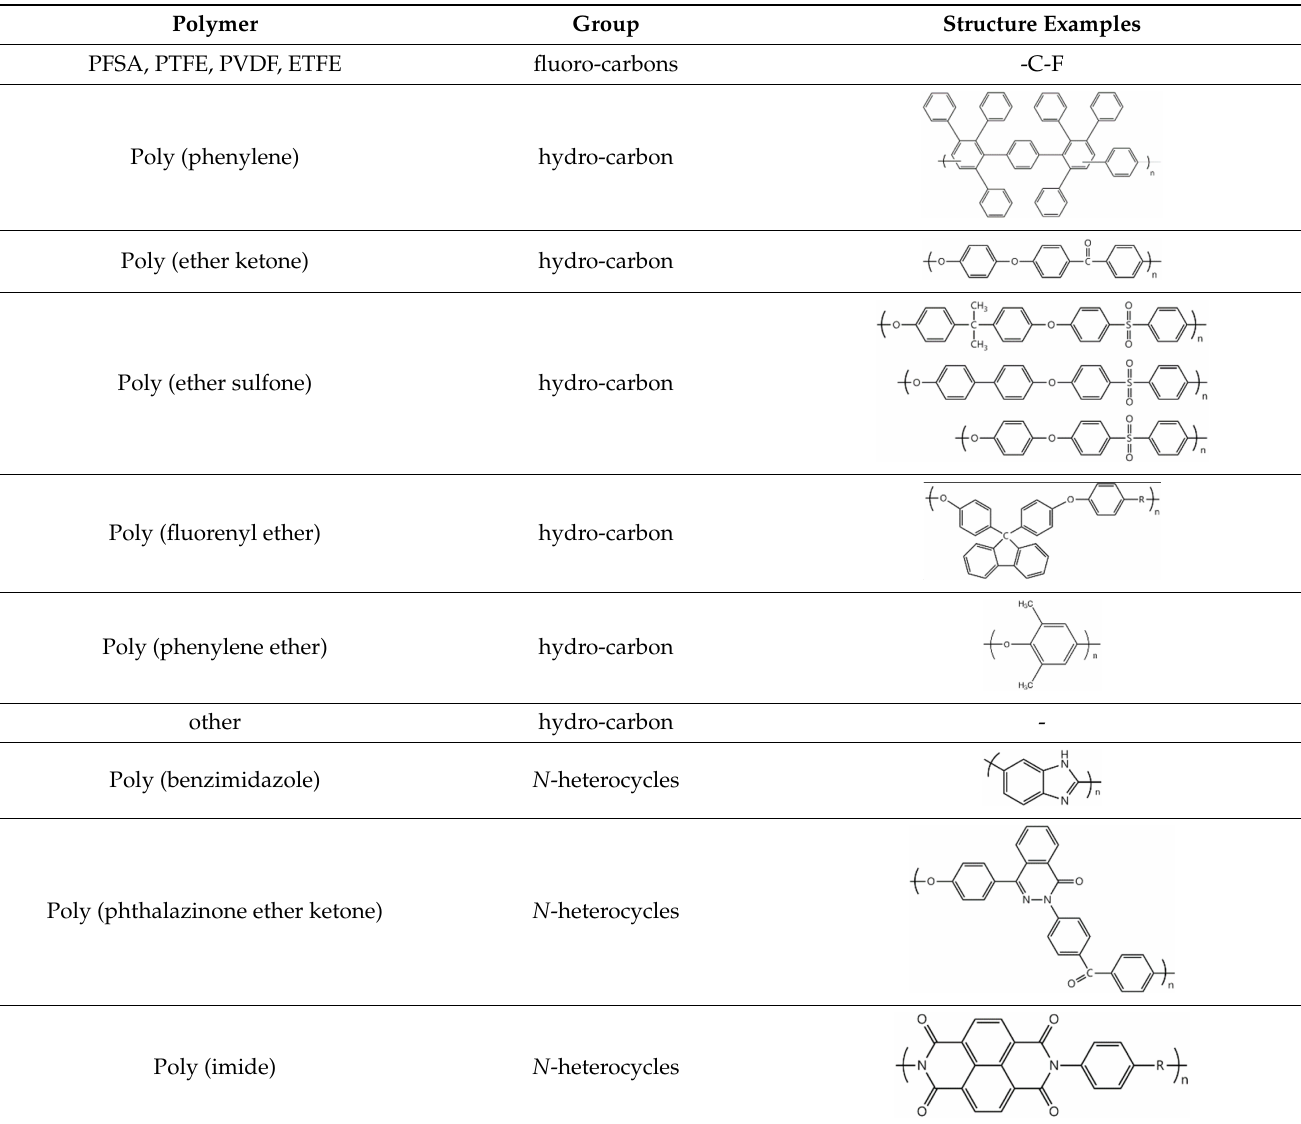
Table 4. Polymers for the preparation of VRFB